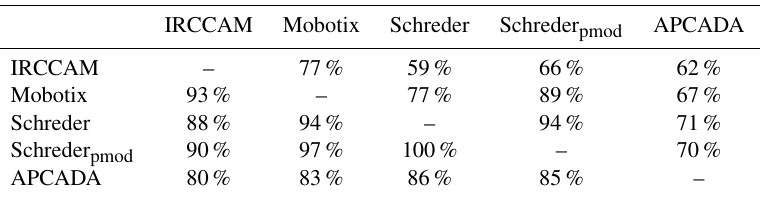
Table 3. Percentage of fractional cloud coverage data which agree within ± 1okta (all values above the main diagonal) and ± 2oktas (all values below the main diagonal) when comparing two algorithms. IRCCAM Mobotix Schreder Schreder pmod APCADA IRCCAM – 77% 59% 66% 62% Mobotix 93% – 77% 89% 67% Schreder 88% 94% – 94% 71% Schreder pmod 90% 97% 100% – 70% APCADA 80% 83% 86% 85% –